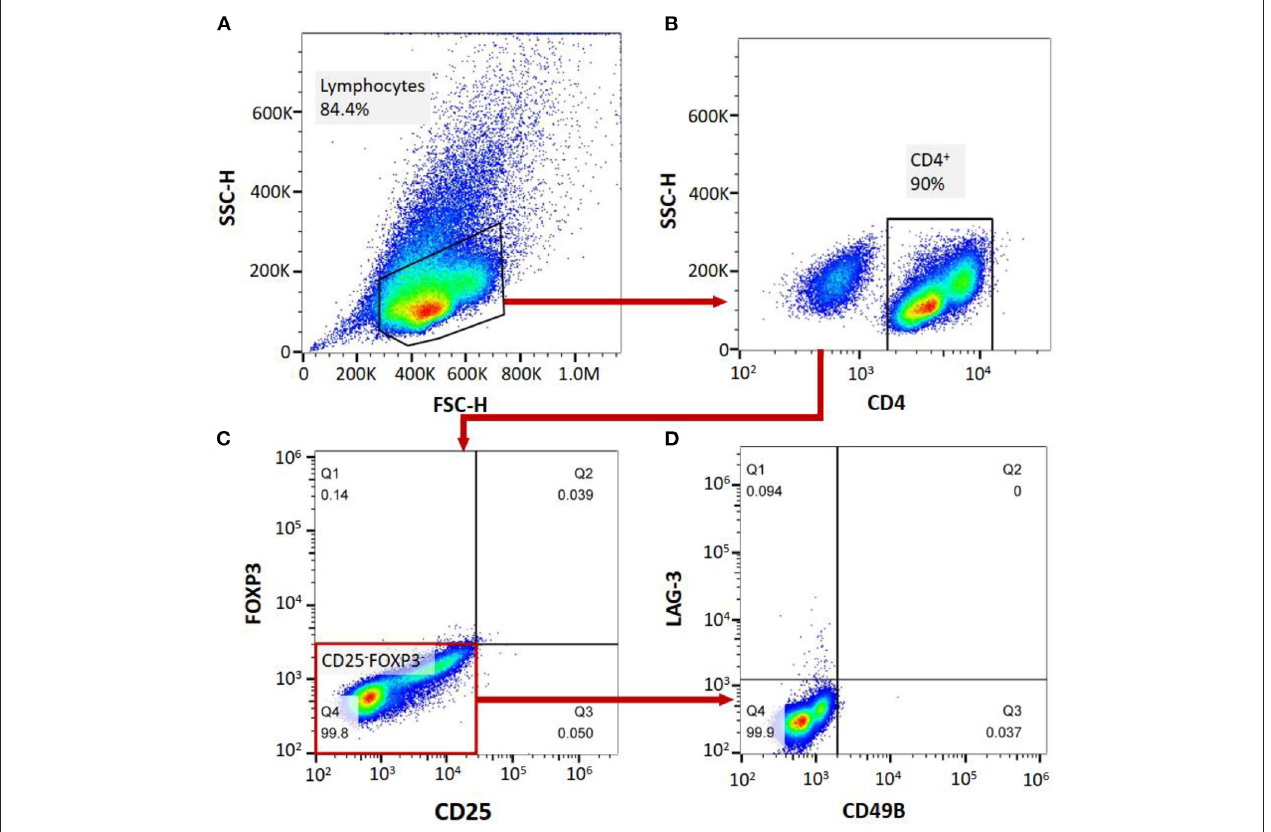
FIGURE 1 | (A–D) , labeling PBMCs with anti-CD4, anti-CD25, anti-FoxP3, anti-CD49B and anti-LAG-3 antibodies, and cell subgroup identification with flow